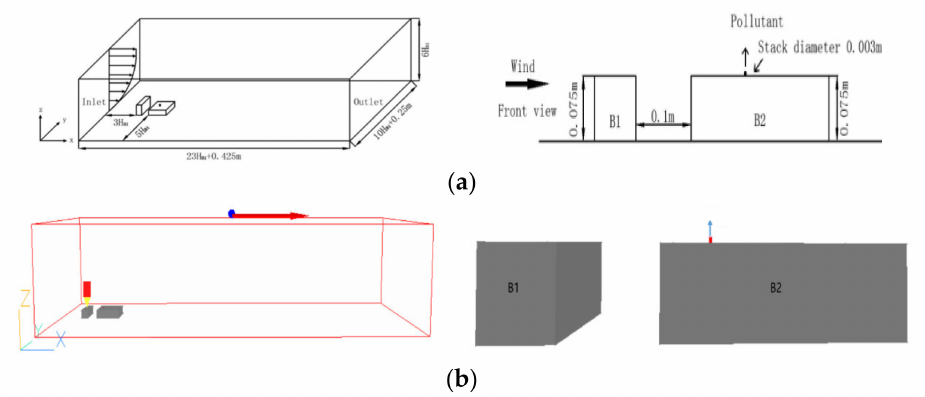
Figure 2. Physical models of the reference paper and CFD: ( a ) models of the reference paper; ( b ) CFD